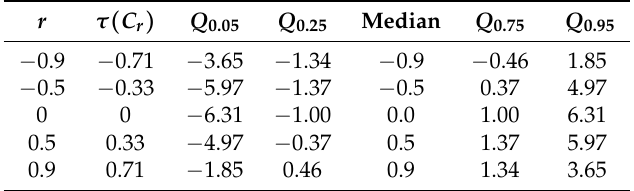
Table 1. Some percentiles of Y = X 1 / X 2 , where ( X 1 , X 2 ) follows Gaussian Copulas.